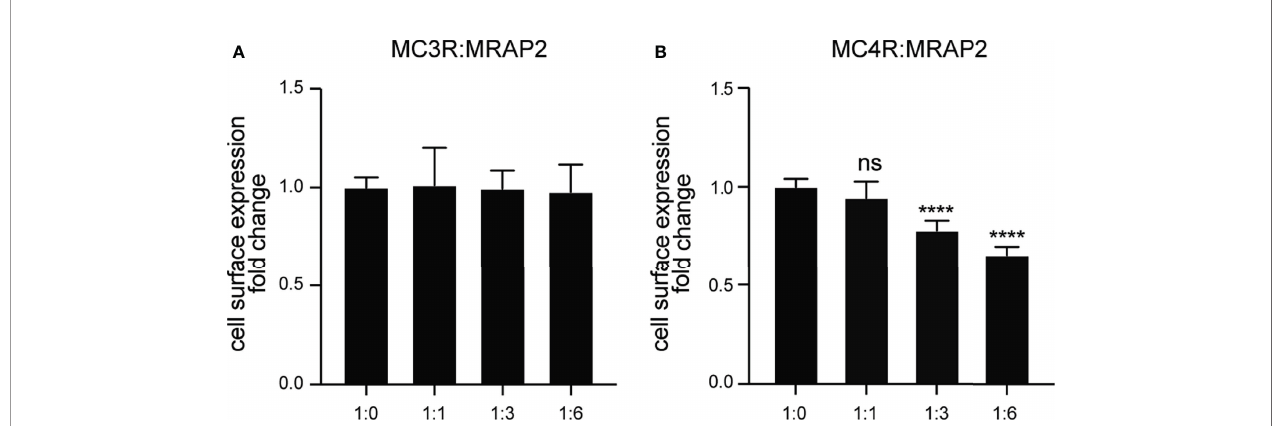
FIGURE 6 | Modulation of the cell surface expression of axolotl MC3R and MC4R by MRAP2. (A) Cell surface expression of axolotl MC3R in presence of different amounts of MRAP2 (1:0, 1:1, 1:3, 1:6). (B) Cell surface expression of axolotl MC4R in presence of different amounts of MRAP2 (1:0, 1:1, 1:3, 1:6). The cell surface expression level of each receptor was expressed as the fold change of the measured surface epitopes level when the receptor was expressed alone (at the plasmid ratio of 1:0). Each data point represents mean ± SEM of three replicates (N = 3). One-way ANOVA with Tukey post-test were performed for all groups of data (****p < 0.0001, ns, not signi fi